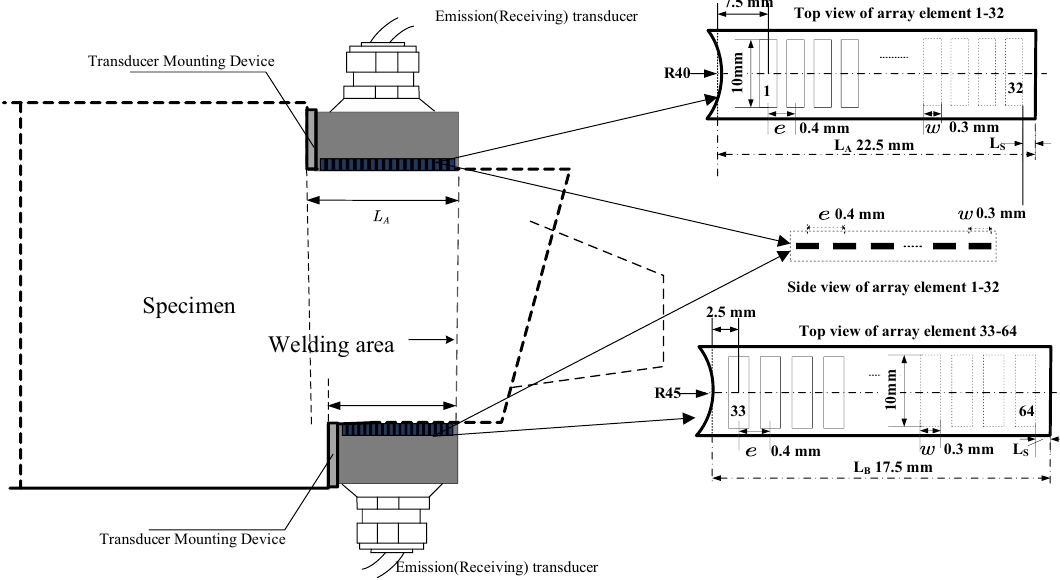
Figure 8. Schematic diagram of the placement of the transducer and the array element dimensions.